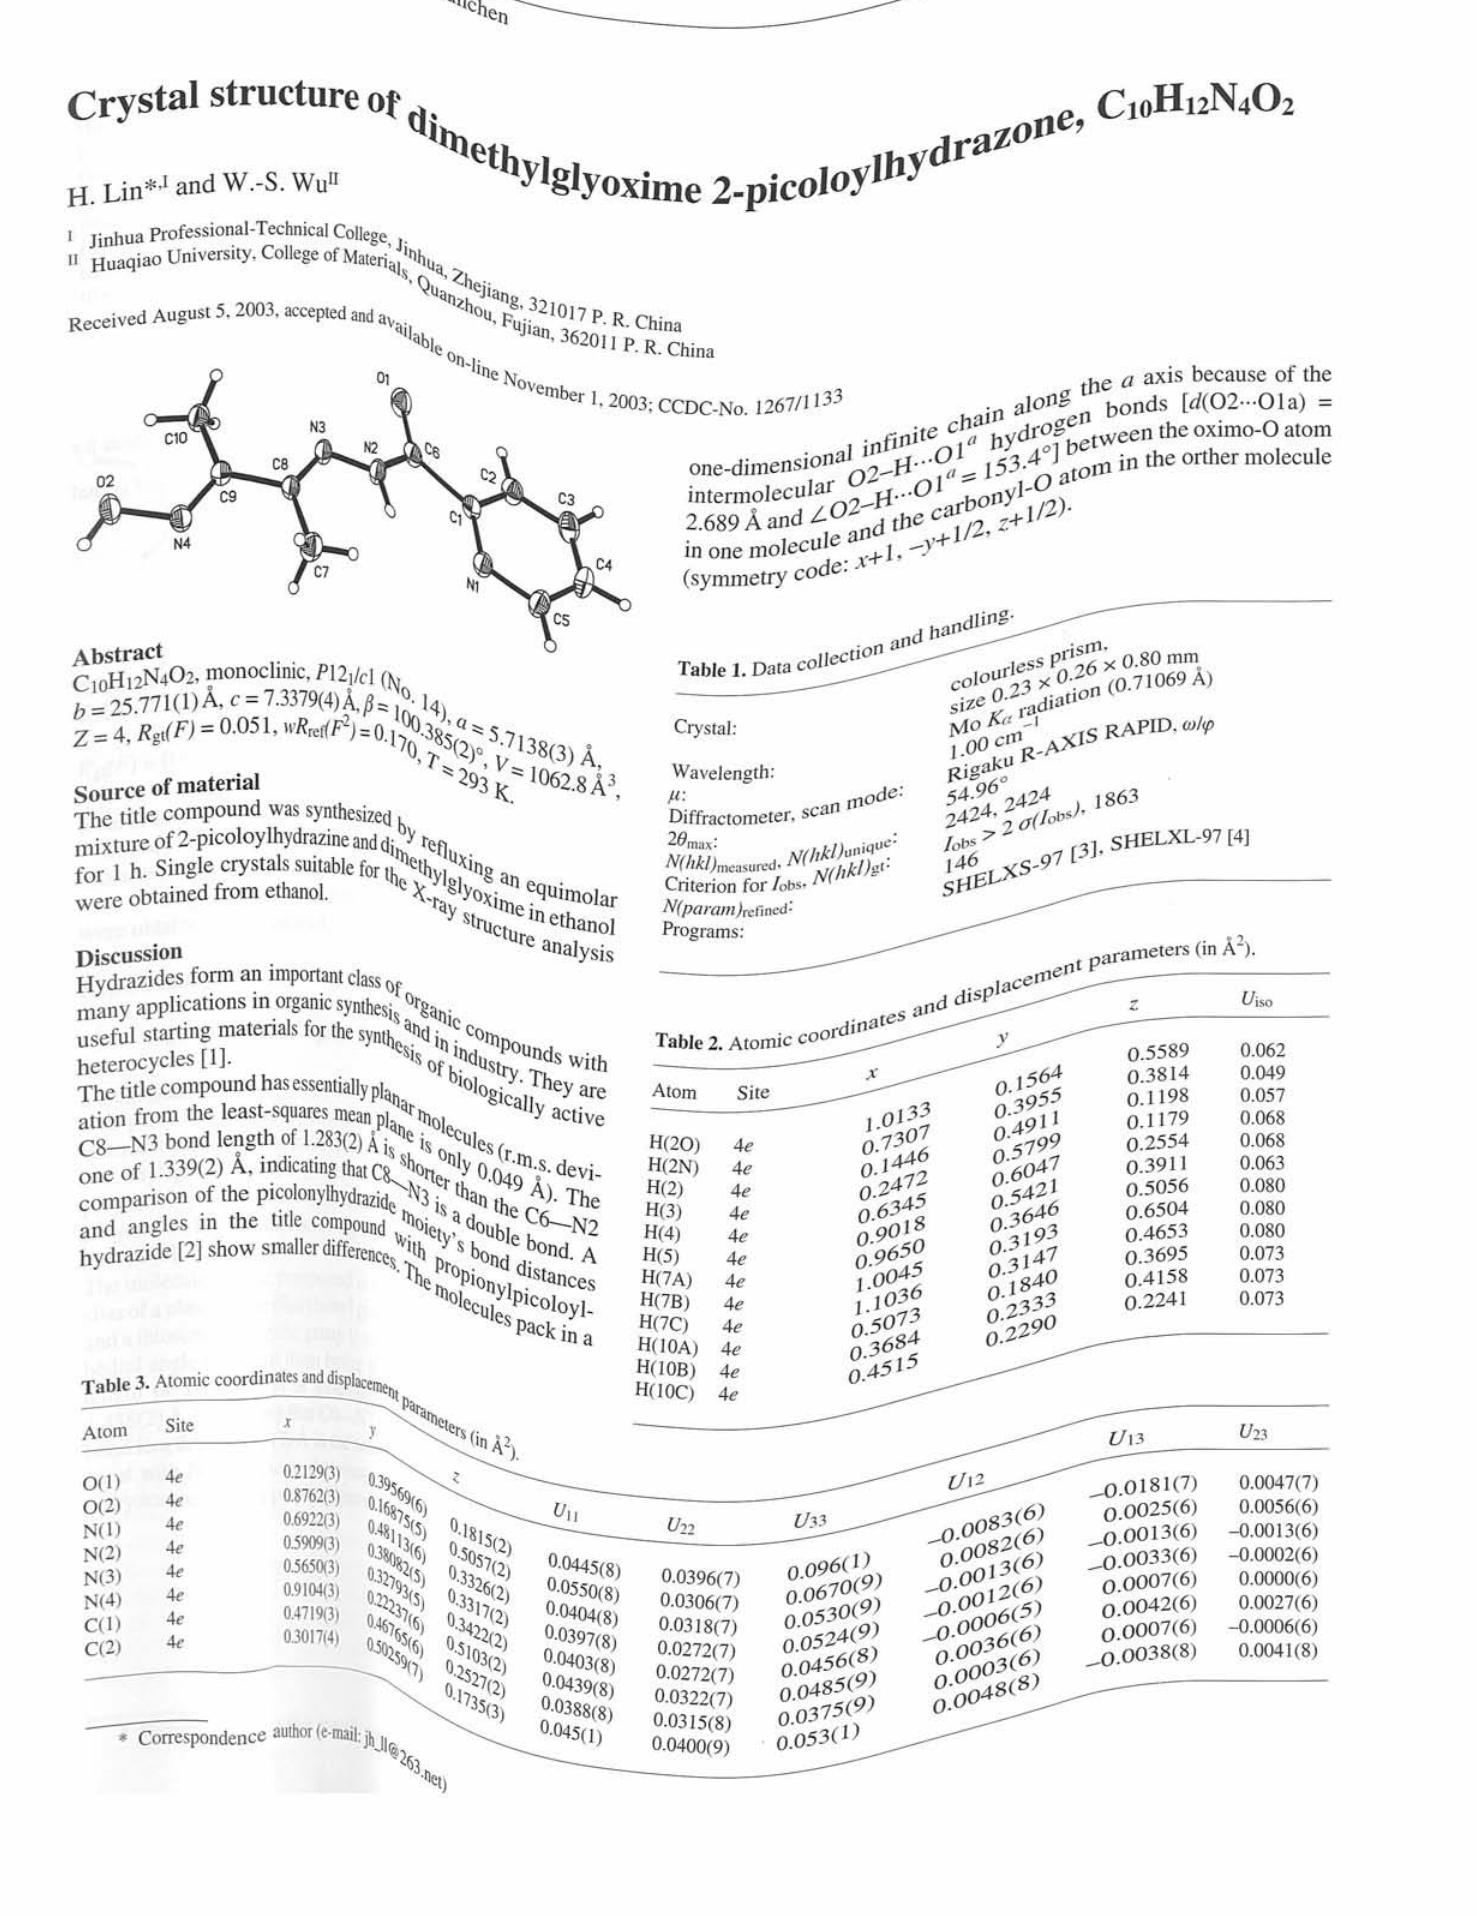
Table 3. Atomic coordinates and